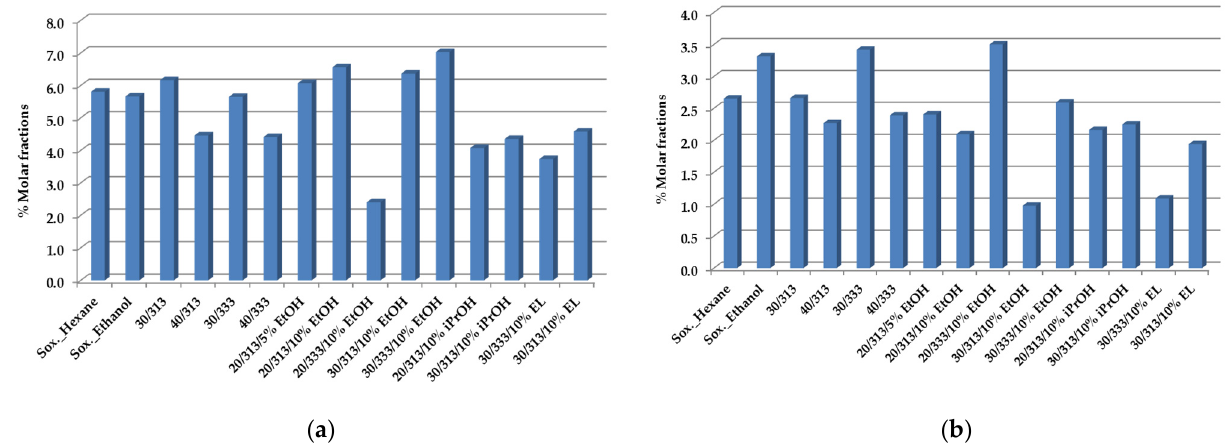
Figure 3. 16-O-Mecafestol ( a ) and kahweol ( b ) composition of spent coffee oils obtained by Soxhlet with hexane, ethanol, and scCO 2 extraction at a flow rate of F = 1.8 × 10 − 3 kg · min − 1 , as established by 1 H-NMR quantitative analysis [50].